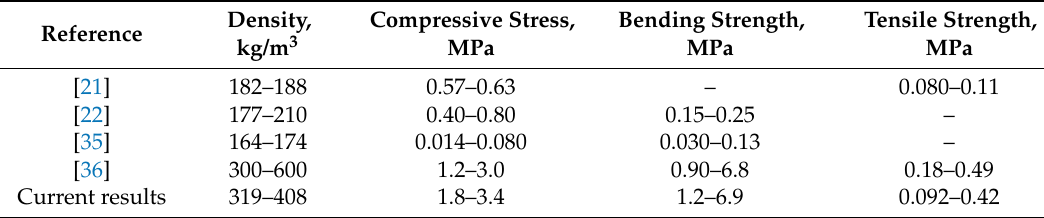
Table 2. Mechanical properties obtained by different authors and the current